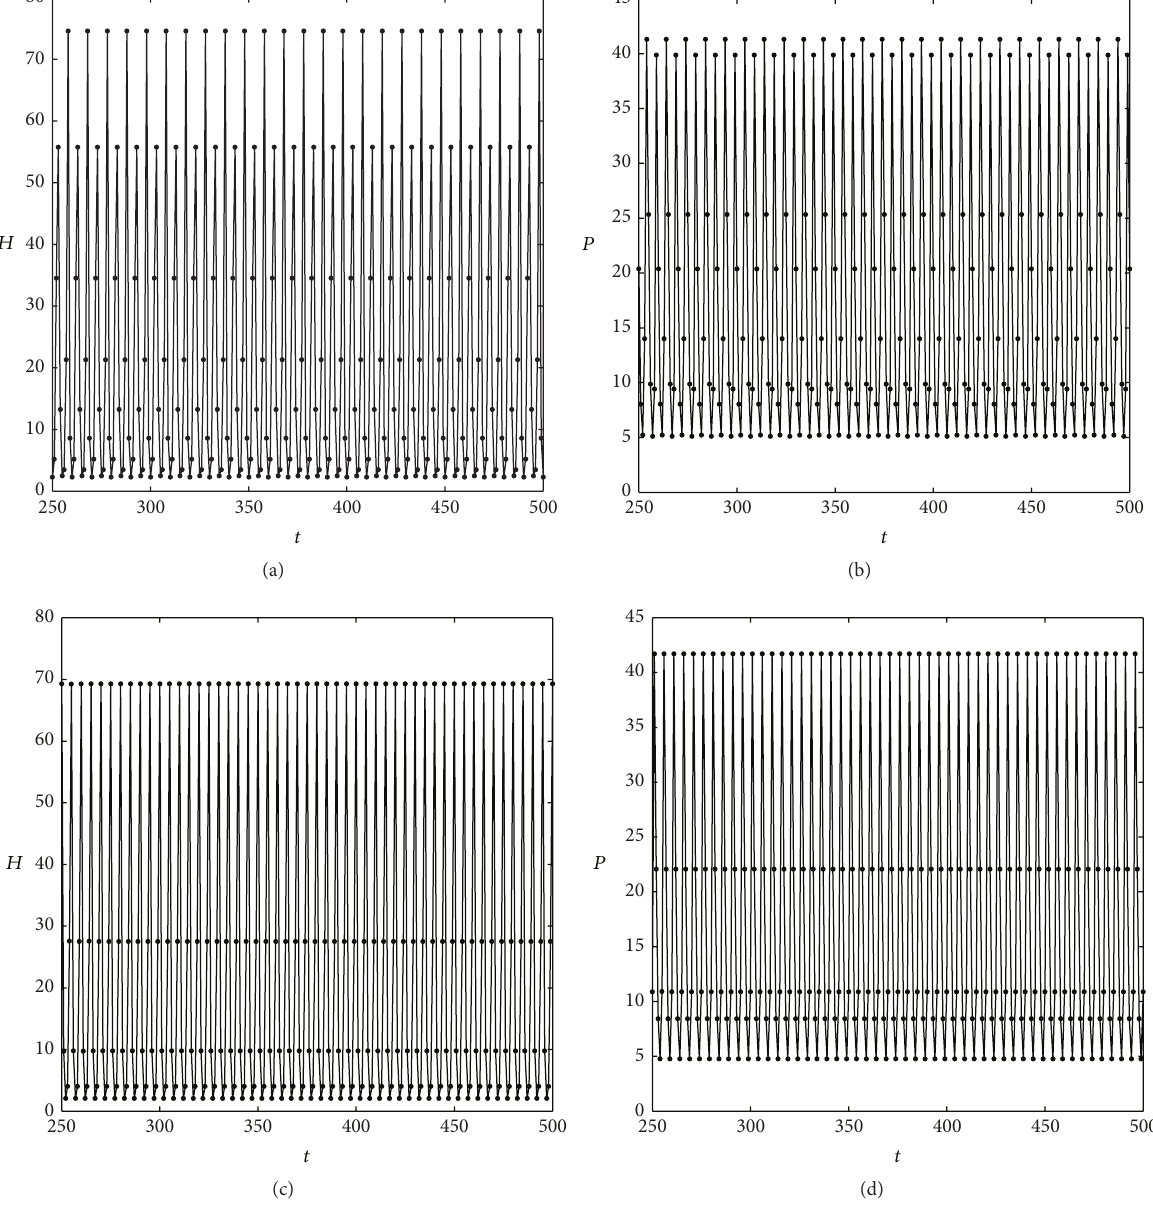
Figure 6: Two attractors’ coexistence. The parameter values are as follows: 𝑇 = 10 , 𝑇 ℎ = 0.5 , 𝐾 = 50 , 𝛿 = 0.3 , 𝛾 = 1 , 𝛼 = 0.01 , 𝜃 = 0 , 𝑞 = 0 , and 𝑟 = 2.99 . The initial values are (5,5) for (a-b) and (1, 2) for (c-d).